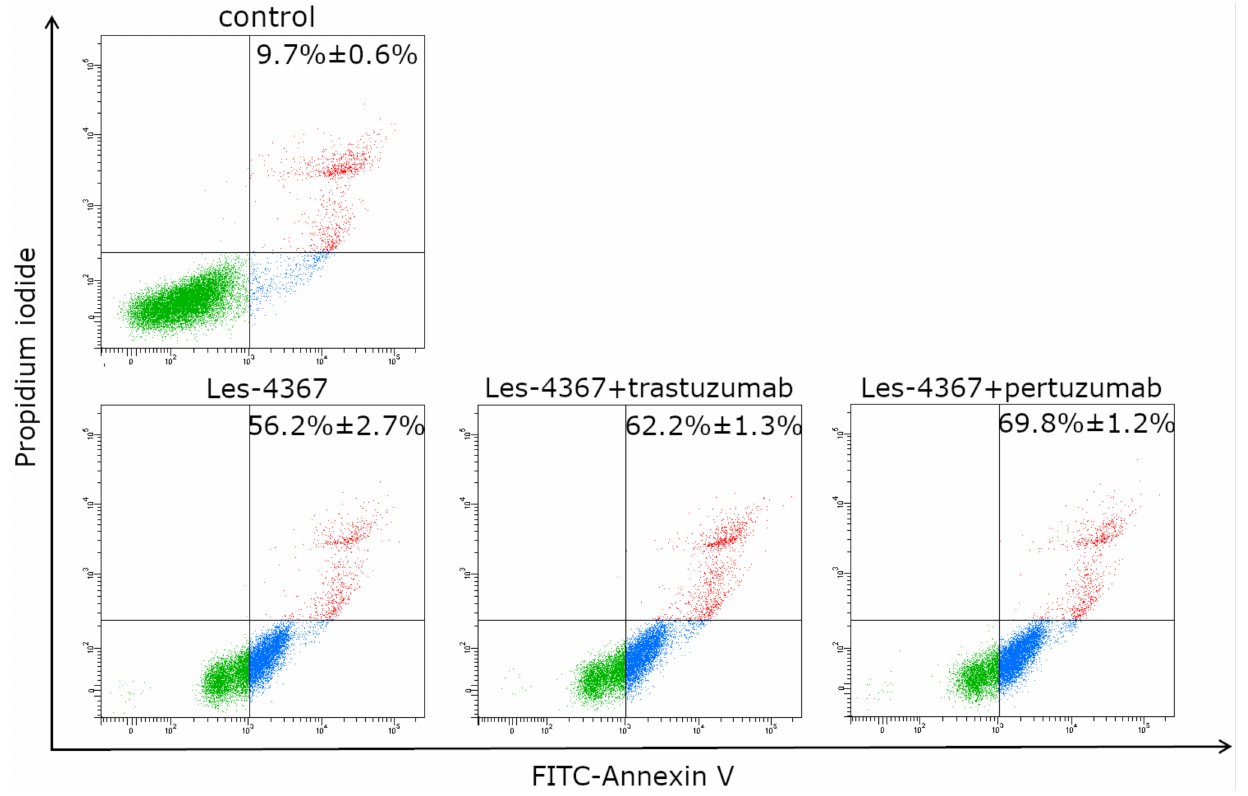
Figure 3. Flow cytometry analysis of AGS human gastric cancer cells after 24 h incubation with Les-4367 alone and combined with trastuzumab or pertuzumab (Les-4367 + trastuzumab, Les-4367 + pertuzumab) and subsequent staining with Annexin V and propidium iodide. The nu- merical value in the upper part of the dot plot = the percentage of cells with early and late apoptosis. Green part of dot plot- live cells, blue part of dot plot- cells with early apoptosis, red part of dot plot- cells with late apoptosis, gray part of dot plot- necrotic cells. The obtained results are presented as mean values ± SD obtained from three independent experiments (n = 3) done in